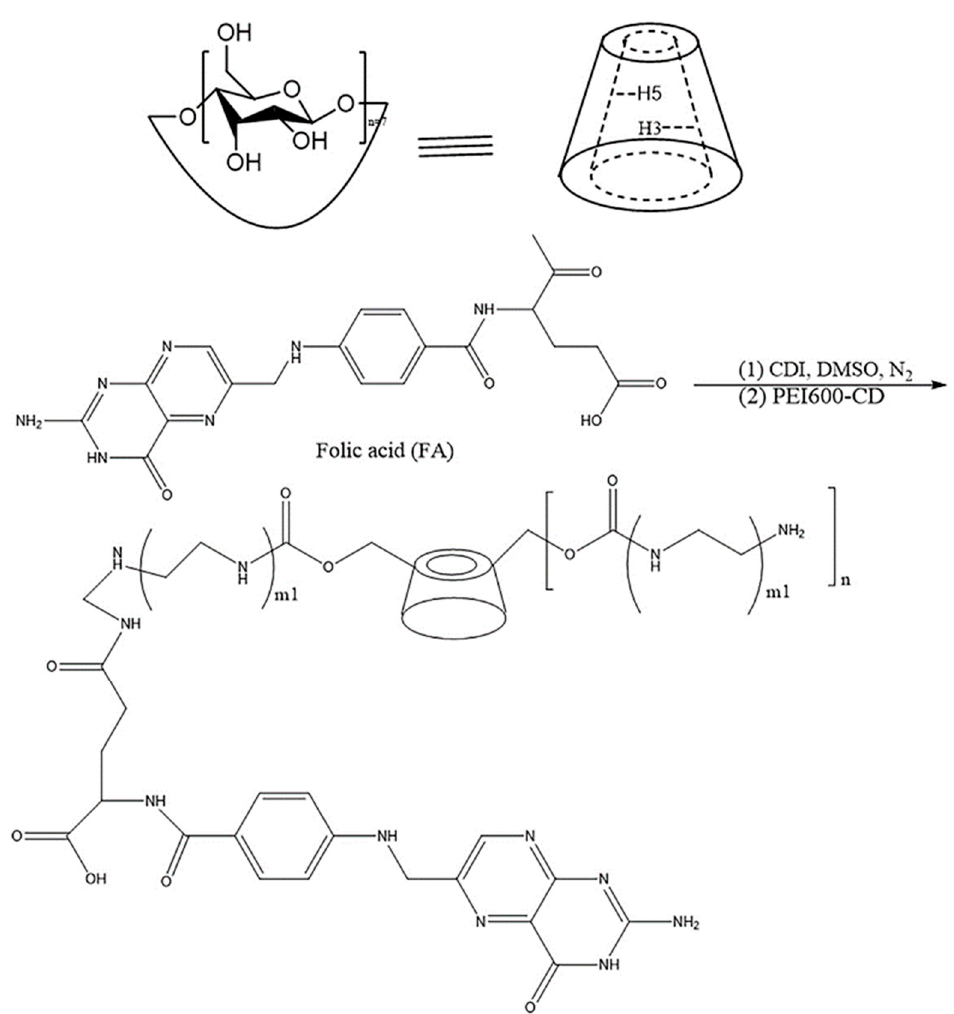
Figure 8. Chemical structures of β -cyclodextrin; the synthesis of FA-PEI- β -CD.